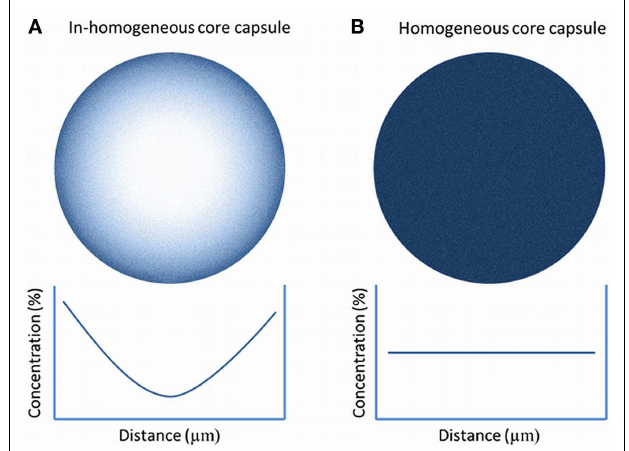
FIGURE 8 |Alginate gradient in in-homogeneous alginate-matrixes (A) and in homogeneous capsules (B) . In in-homogeneous capsules, the concentration of alginates decrease gradually toward the center of the capsule while in the homogeneous capsule the alginate concentration is